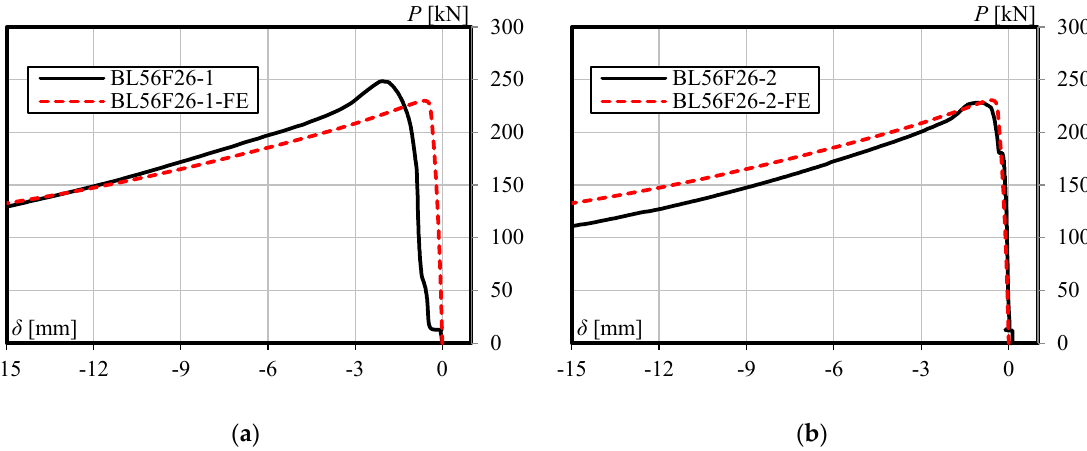
Figure 6. Load versus lateral mid-height deflection response for specimen having a strengthening length of 260 mm: ( a ) BL56F26-1, and ( b ) BL56F26-2.